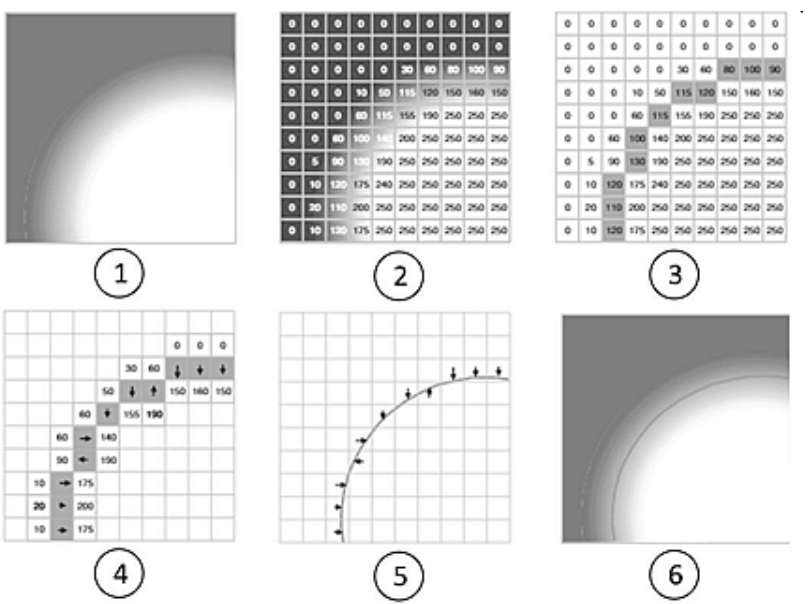
Figure 1. Following steps of the digital outline designation: ( 1 ) original image; ( 2 ) digital image; ( 3 ) pixel contour; ( 4 ) subpixel contour; ( 5 ) aligned outline (equation calculus method); ( 6 ) application of the outline to the original image.